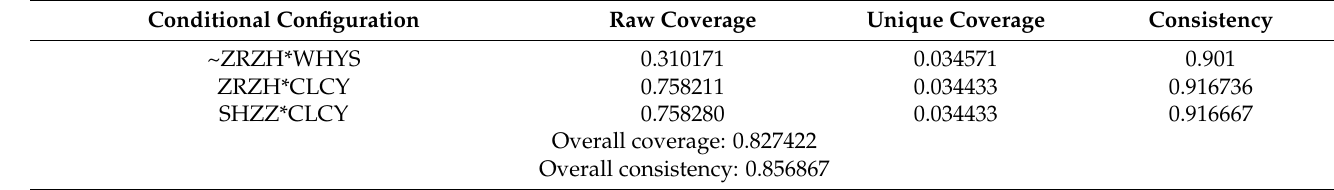
Table 10. Parsimonious solution.